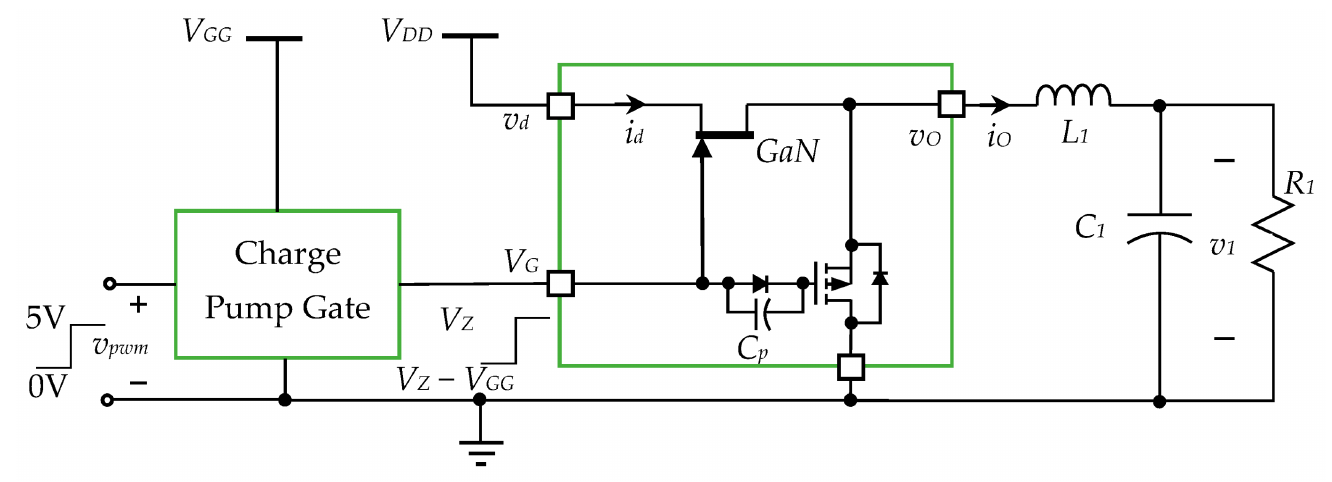
Figure 14. Synchronous buck converter using the P-Cascode GaN HEMT. The GaN HEMT switches between the on and off states during operation. When GaN